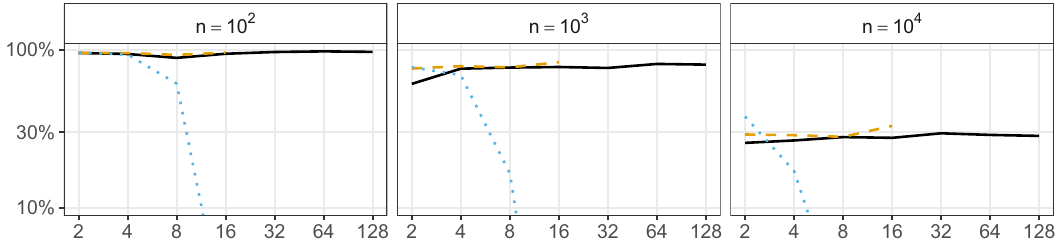
Figure 6: The setup activities ’ proportion of the median runtime of the MDCM ( solid, black ) , AM ( dashed, yellow ) , and ESM ( dotted, blue ) algorithms for extMO distributions from the exponential family with drift and without killing, calibrated to unit exponential margins and a bivariate lower - tail dependence coe ffi cient of 50%. We measured the setup activities ’